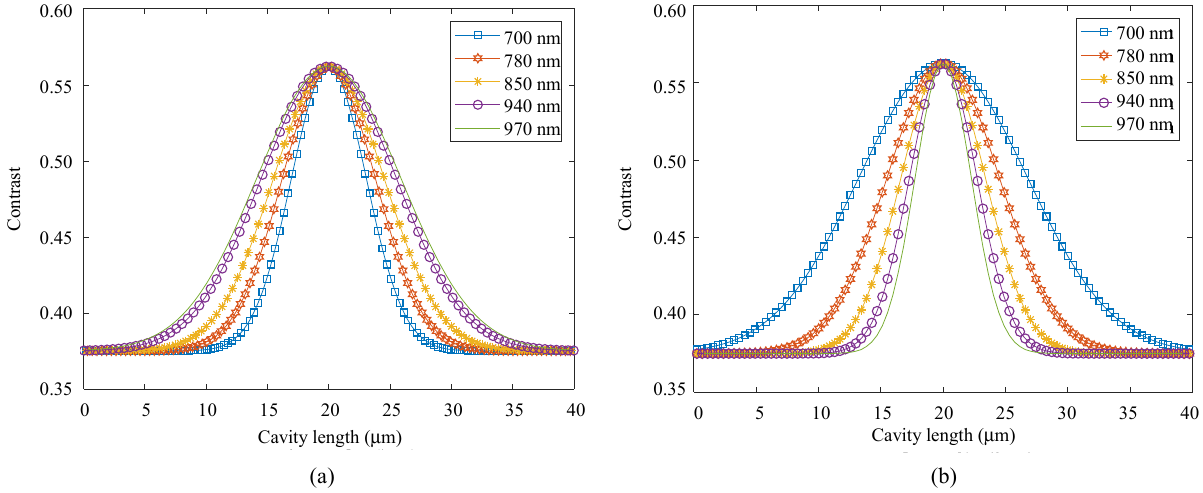
Fig. 8 Signal contrast at different center wavelength or bandwidth: (a) signal contrast at different center wavelengths and (b) signal contrast at different